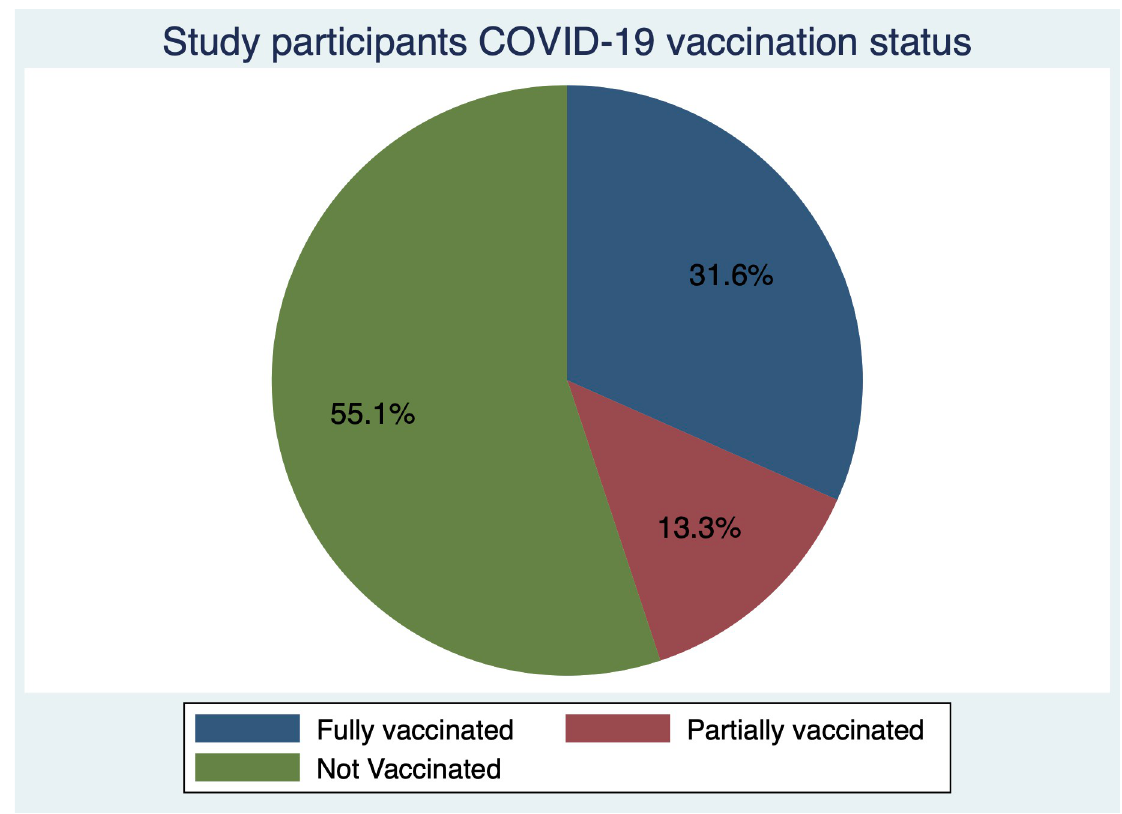
Fig 3. Vaccination status of the study